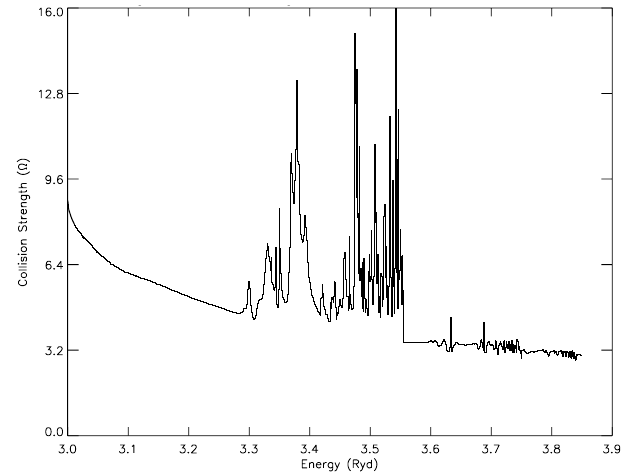
Figure 8. Collision strengths for the 2p 2 P o